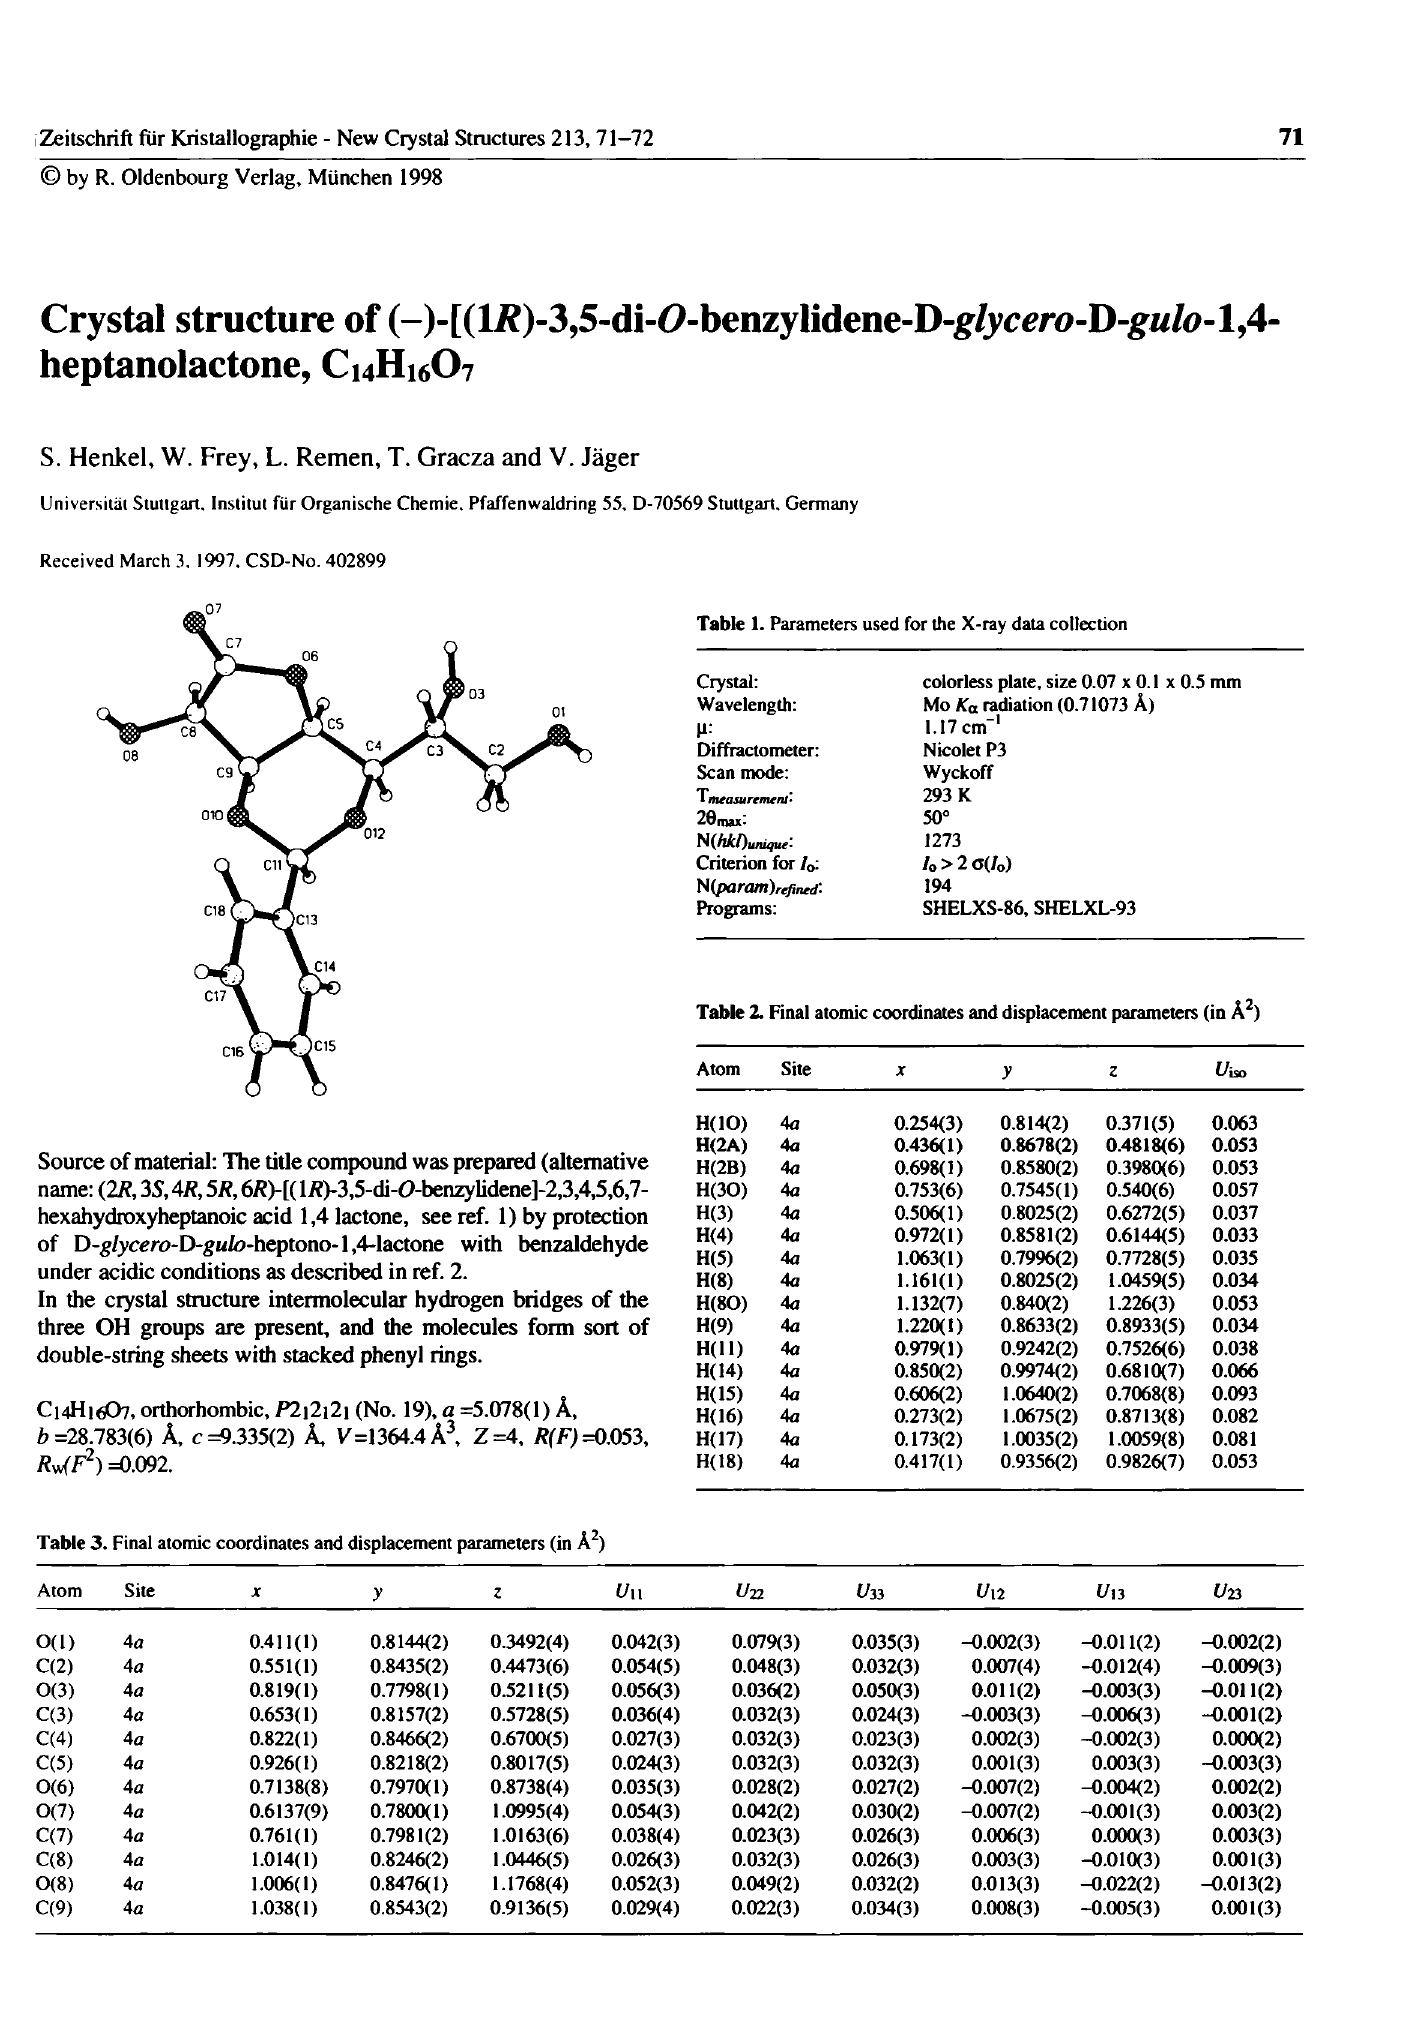
Table 3. Final atomic coordinates and displacement parameters (in Â^)